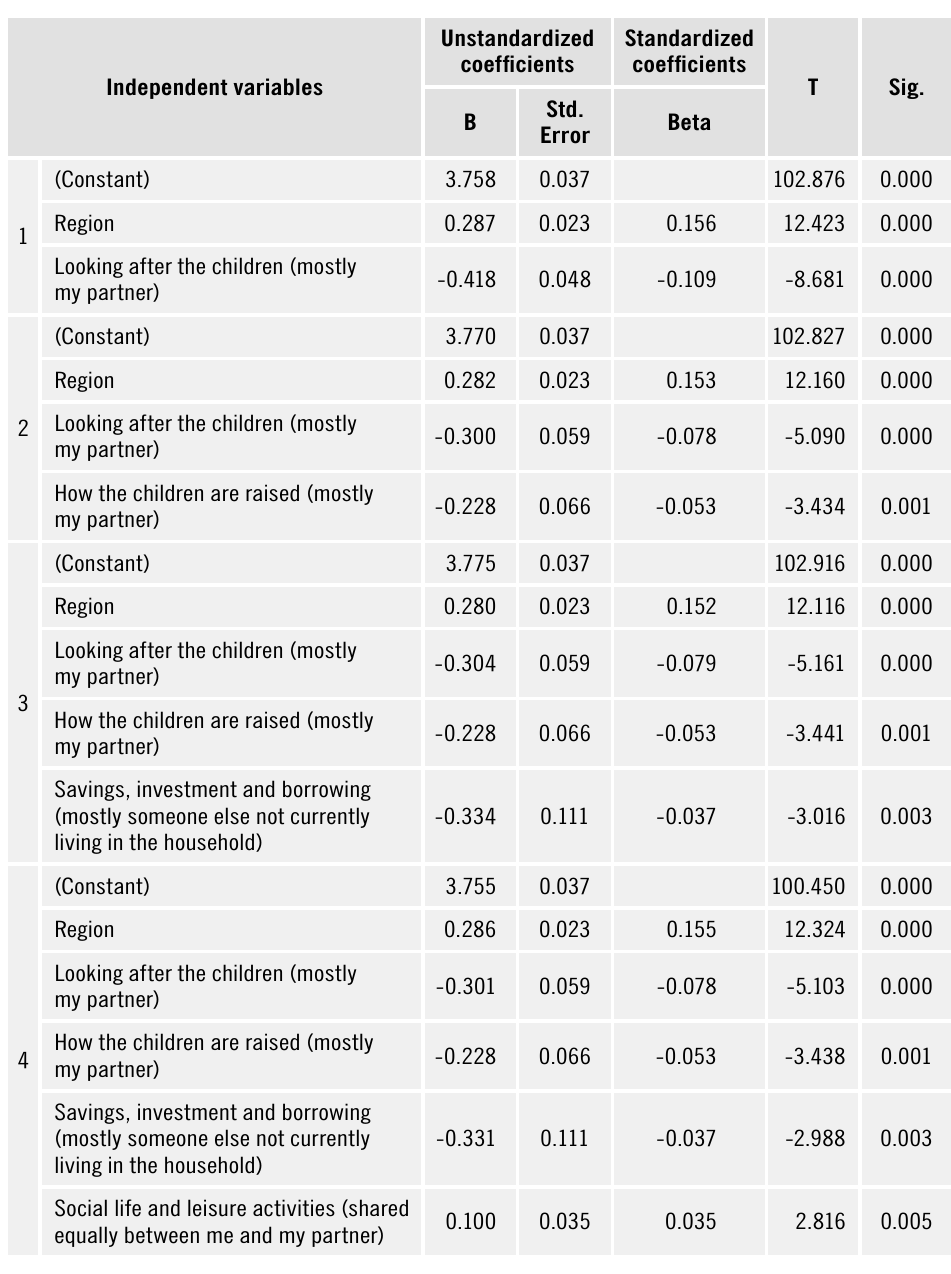
Table 4. Regression model illustrating the significance of the region and decision-making power for